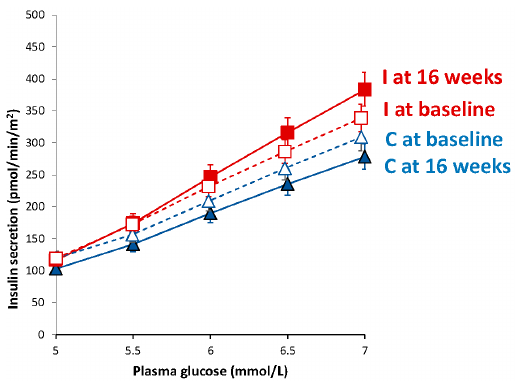
Figure 2. Dose-response insulin secretion in response to different plasma glucose levels. Triangles with the blue line represent the control group (empty triangles and a dashed line at baseline, and full triangles with a full line at 16 weeks), while squares with the red line show data from the intervention group (empty squares with a dashed line at baseline, and full squares with a full line at 16 weeks). Data are given as means with 95% CIs.